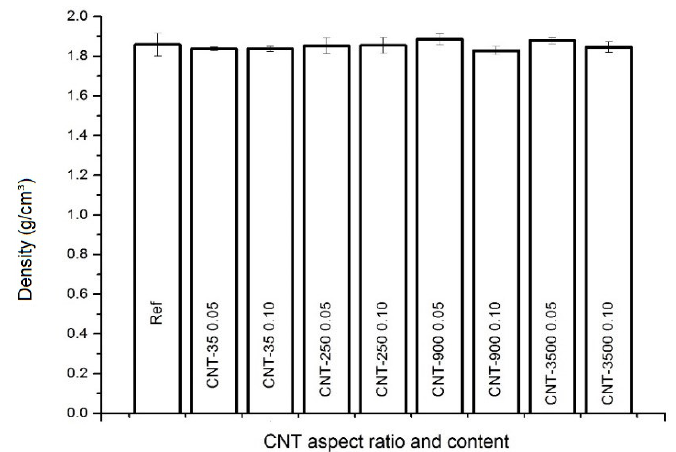
Figure 5. Density of the cement pastes.